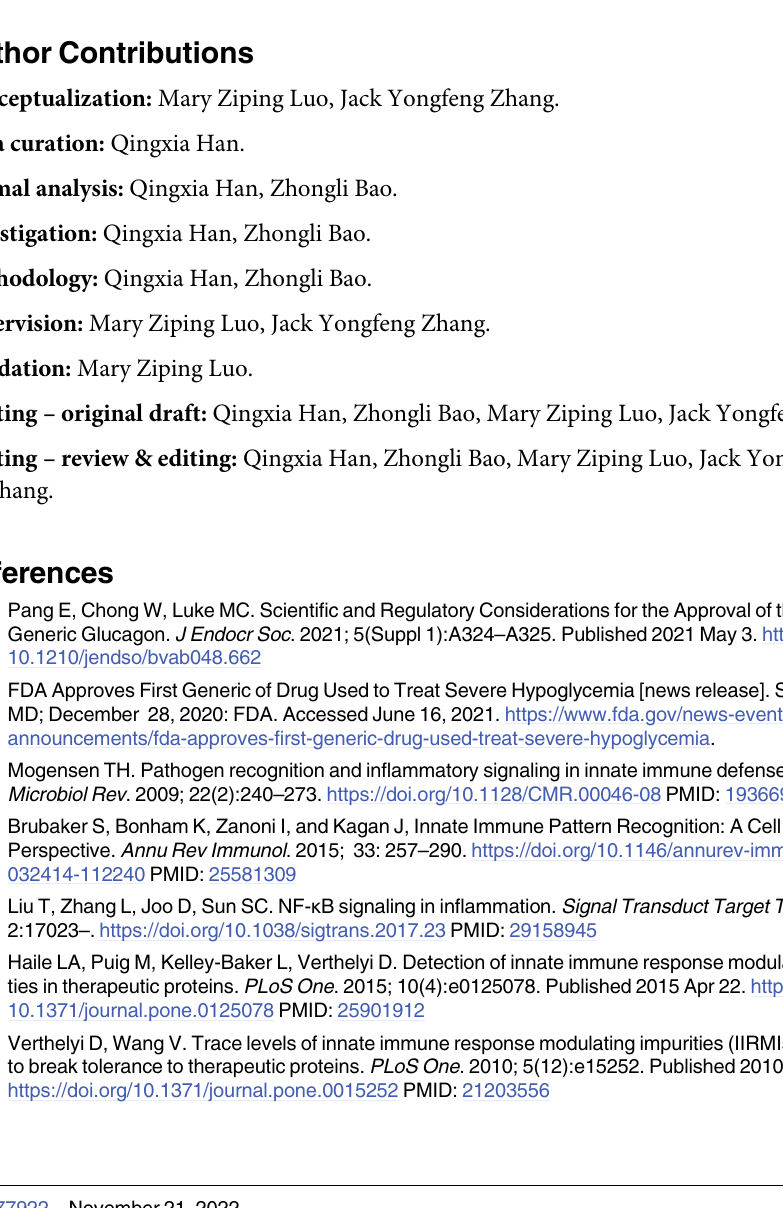
S1 Table. Summary of innate immunogenicity masking assessment assay. The highlighted data indicate the potential LLOD concentrations of the ligand which elicited higher innate immune response with a p -value close to 0.05, when compared to its correspondent "0 ng/ml" negative